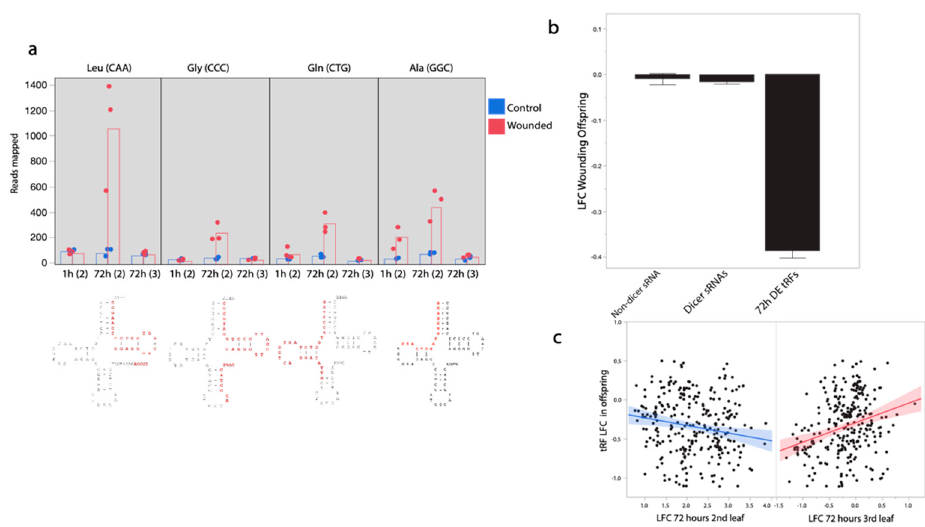
Figure 3. Differential production of tRNA-derived small RNAs (tRFs) in response to leaf wounding. ( a ) tRFs mapping to both the 5 ′ and 3 ′ end of tRNA loci but not the anticodons, show increases in tRF sRNA production in 2nd pair wounded leaves. Levels of tRF abundances from three tRNAs with the strongest pattern of differential tRF abundances are shown, as well as with significant increase in tRF abundances at both the 1 and 72 h timepoints. tRNA structure below with primary tRF sRNA fragment detected here in red. Leaf pair in parentheses Leu = Leucine, Gly = Glycine, Gln = Glutamine, Ala = Alanine. ( b ) tRF loci with increased expression 72 h after wounding in the wounded leaf, tend to have decreased expression in the following generation. ( c ) When modeled together, there is a negative relationship between log-fold changes (LFC) in the second leaf pair and LFC in the offspring for tRFs but a positive relationship between LFC in the third leaf pair and LFC in the offspring generation.